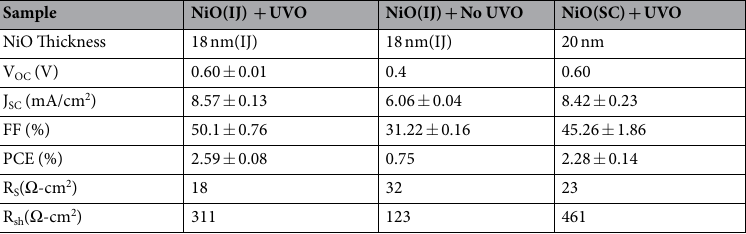
Table 1. Device parameters of P3HT:PC 60 BM organic solar cell devices fabricated on inkjet printed as well as spin coated NiO films used as HTL on ITO/Glass substrate, both heat treated at 400 °C and surface treated prior to device fabrication (UVO: UV Ozone, IJ: ink-jet printed, SC: spin